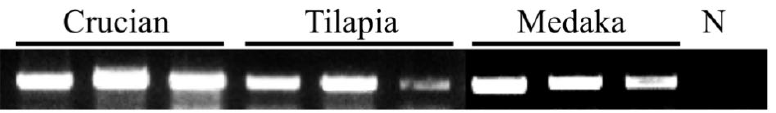
Figure 5. PCR results from DNA extracted from skin mucus by the swabbing and disc method from fish of different sizes: three crucian carp (~7 cm); three tilapias (~15 cm); and three medakas (~2.5 cm). N, no template control. The eluted DNA was used in PCR reaction using primers designed for the 16s rRNA gene.